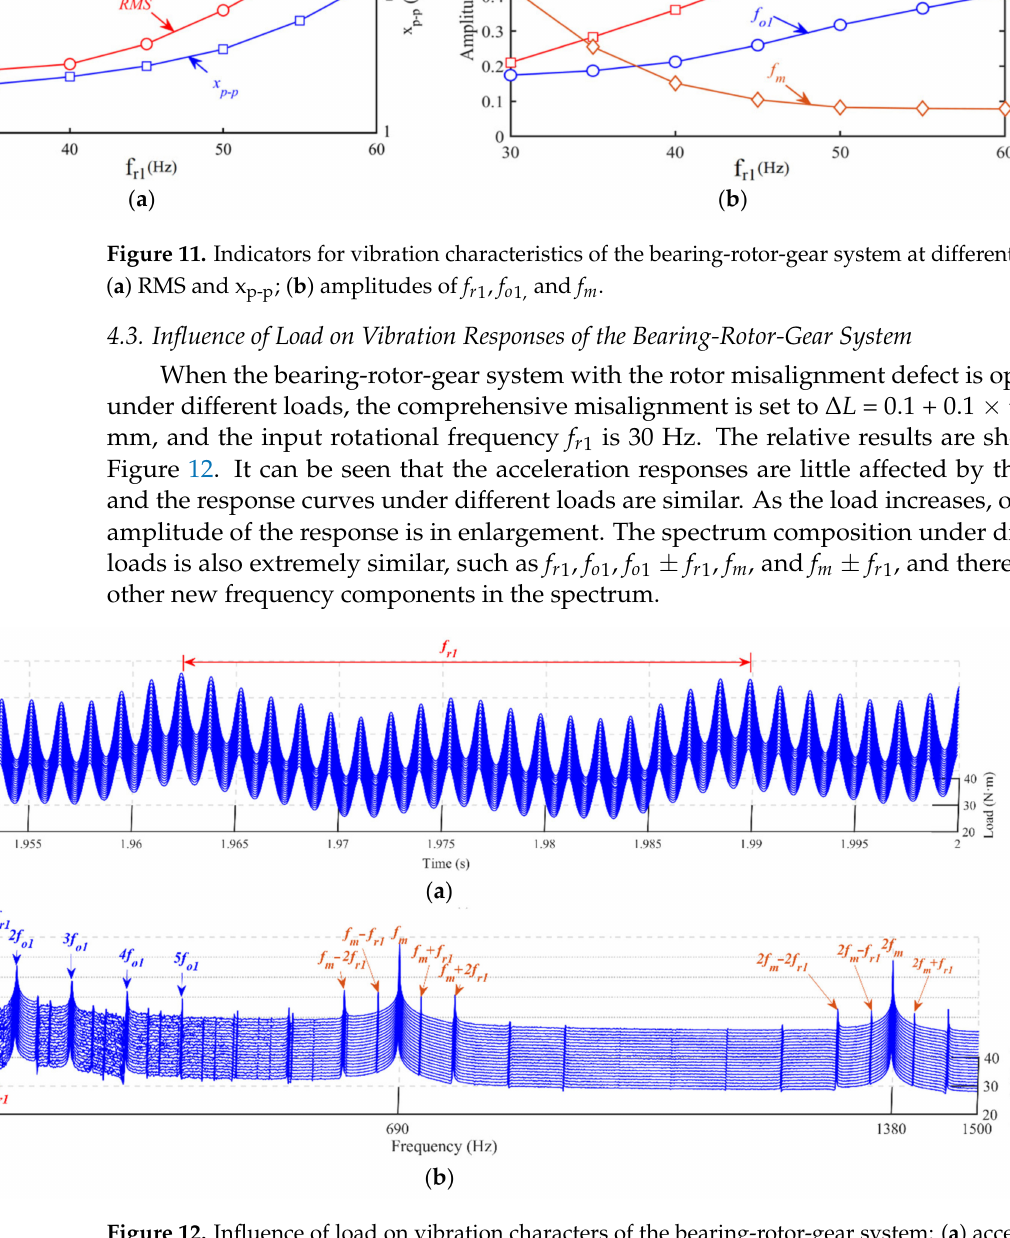
Figure 12. Influence of load on vibration characters of the bearing-rotor-gear system: ( a ) acceleration responses; ( b ) frequency